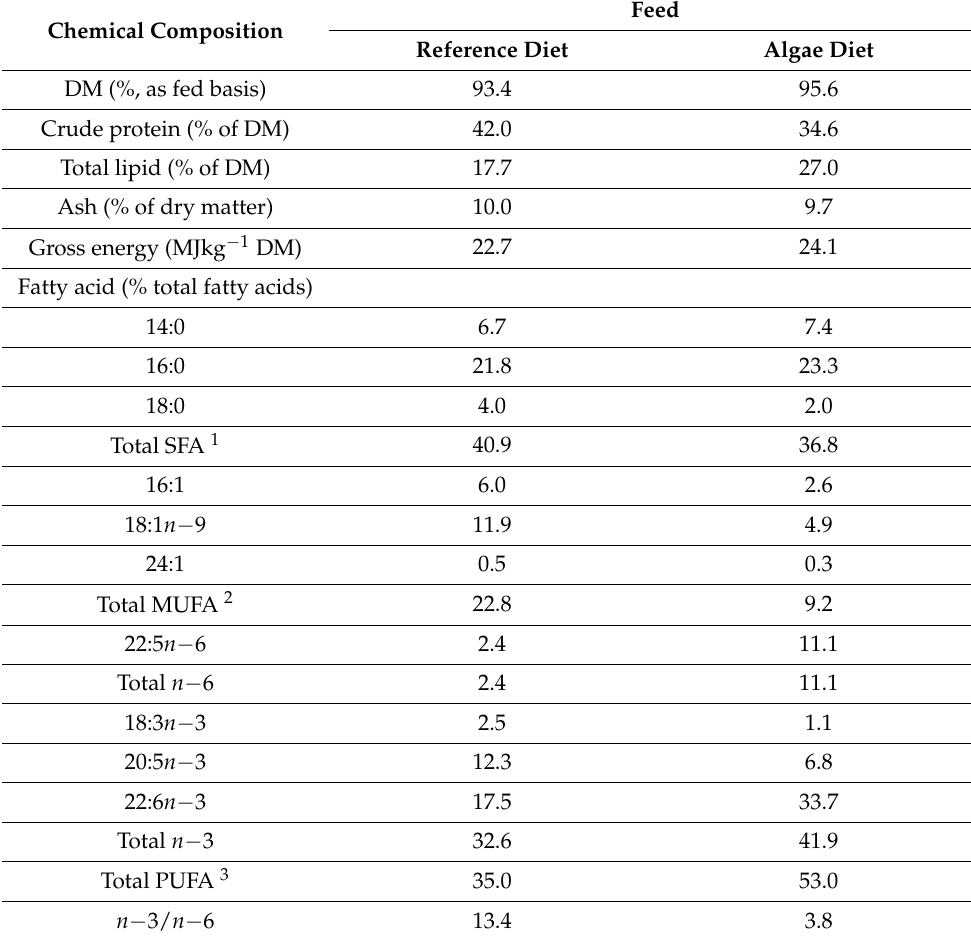
Table 3. Chemical composition and fatty acid profile of the feeds. Chemical